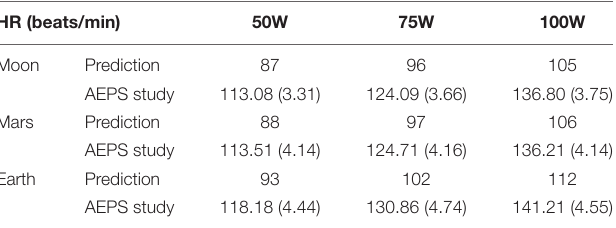
TABLE 5 | Comparison between Bonjour’s predictions of the heart rate responses to exercise on Moon and Mars with the results obtained in this study [mean (SE), including 14